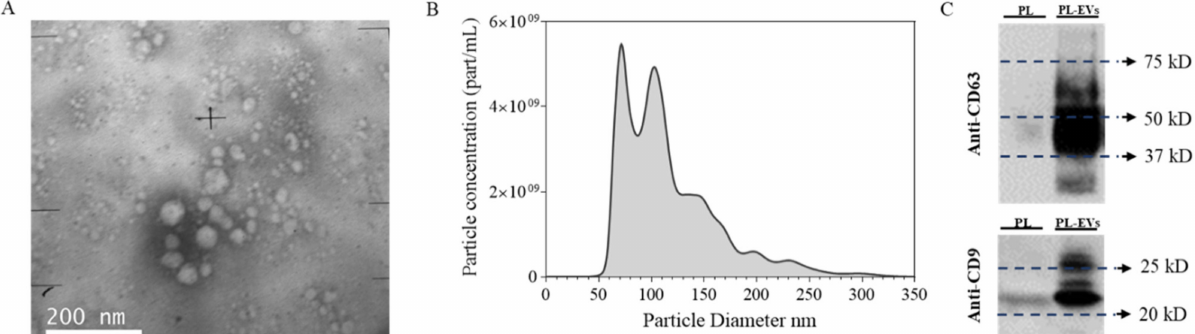
Figure 1. Platelet-derived extracellular vesicle characterization. ( A ) Wide-field TEM image of PL- EVs taken at × 100k augments. ( B ) Particle size distribution of EVs determined by NTA analysis. ( C ) Presence of EV biomarkers CD63 and CD9 for PL and PL-EVs. The same amount of protein was loaded per well (5 µ g).